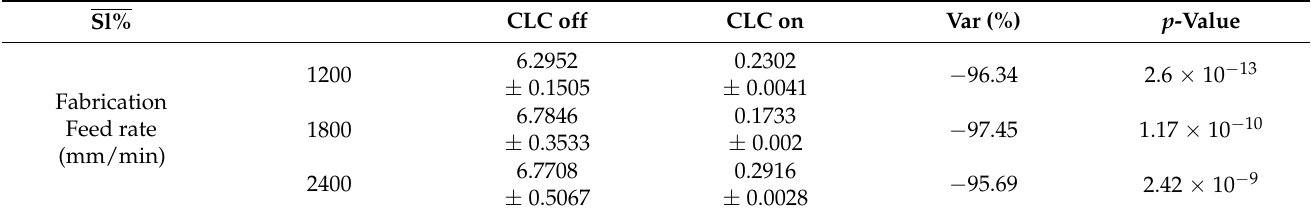
Table 5. Mean values of slippage.